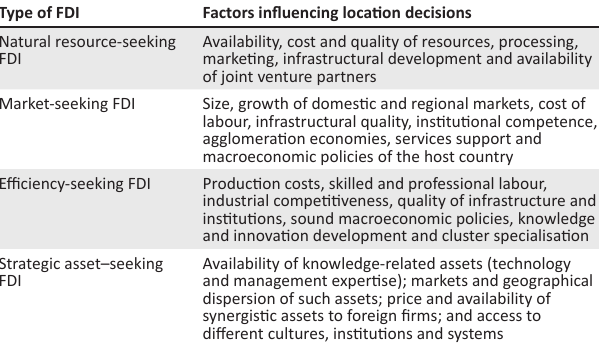
TABLE 1: Location decision of foreign direct investments to the host